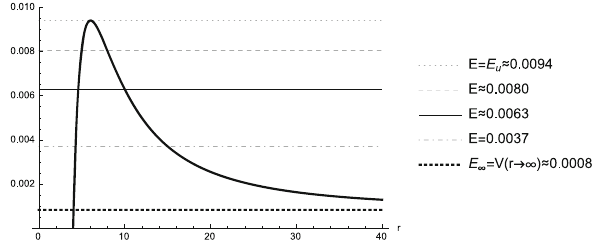
Fig. 6 The behavior of the effective potential for photons as a function of r , for L = 1, M = 2, m p = 1, and z =